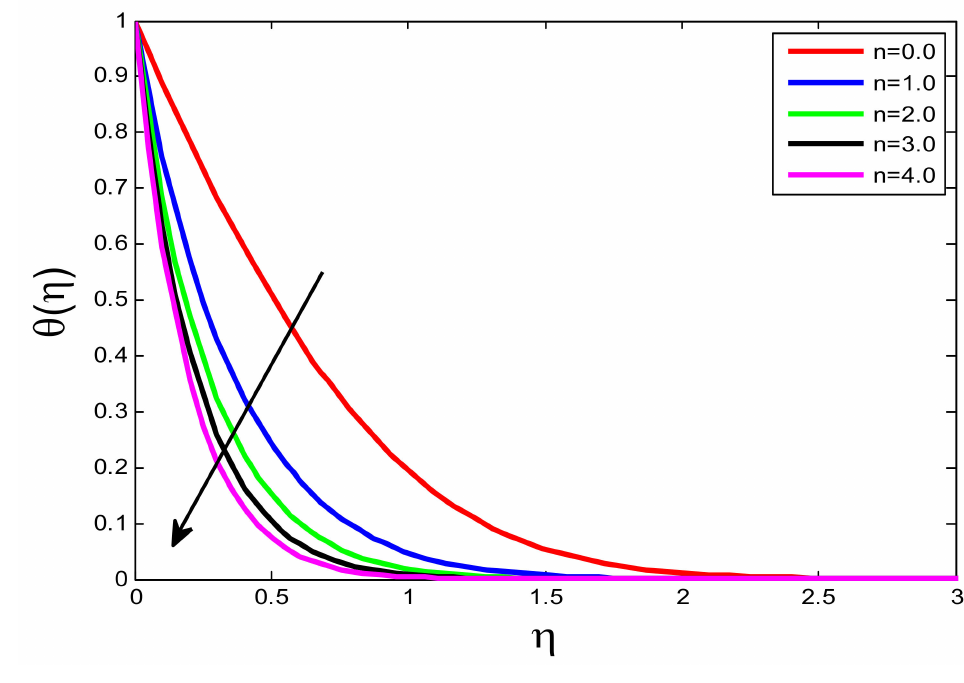
Figure 6. Influence of n on θ ( η ) .